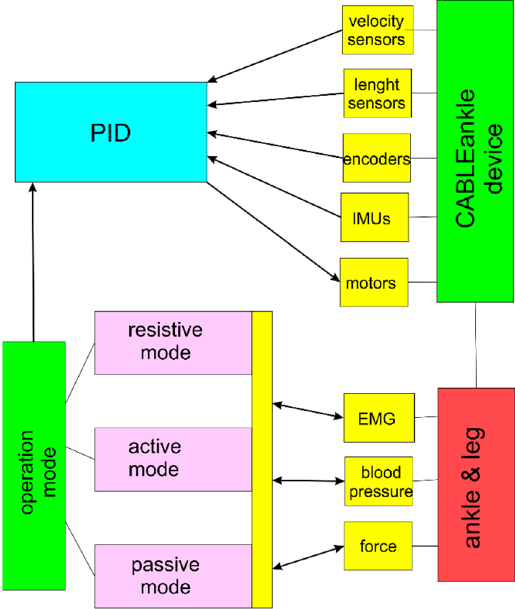
Figure 5. A scheme for control design in CABLEankle device. Resistive mode and co-operative mode fall under the category of active